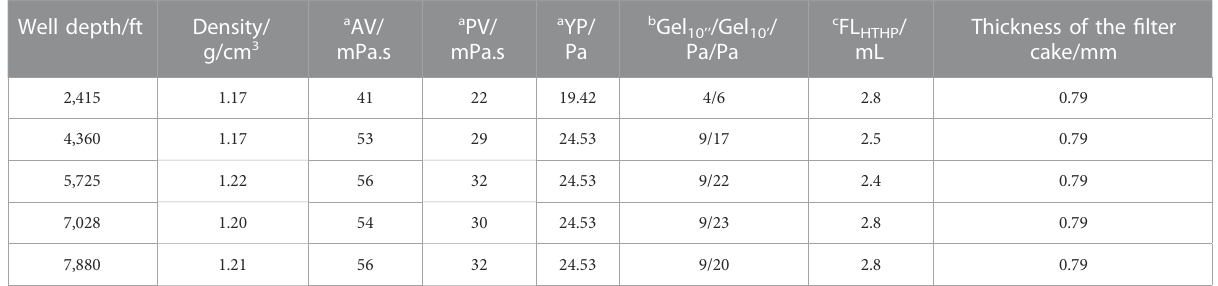
TABLE 2 Basic performance of ULTRADRILL.